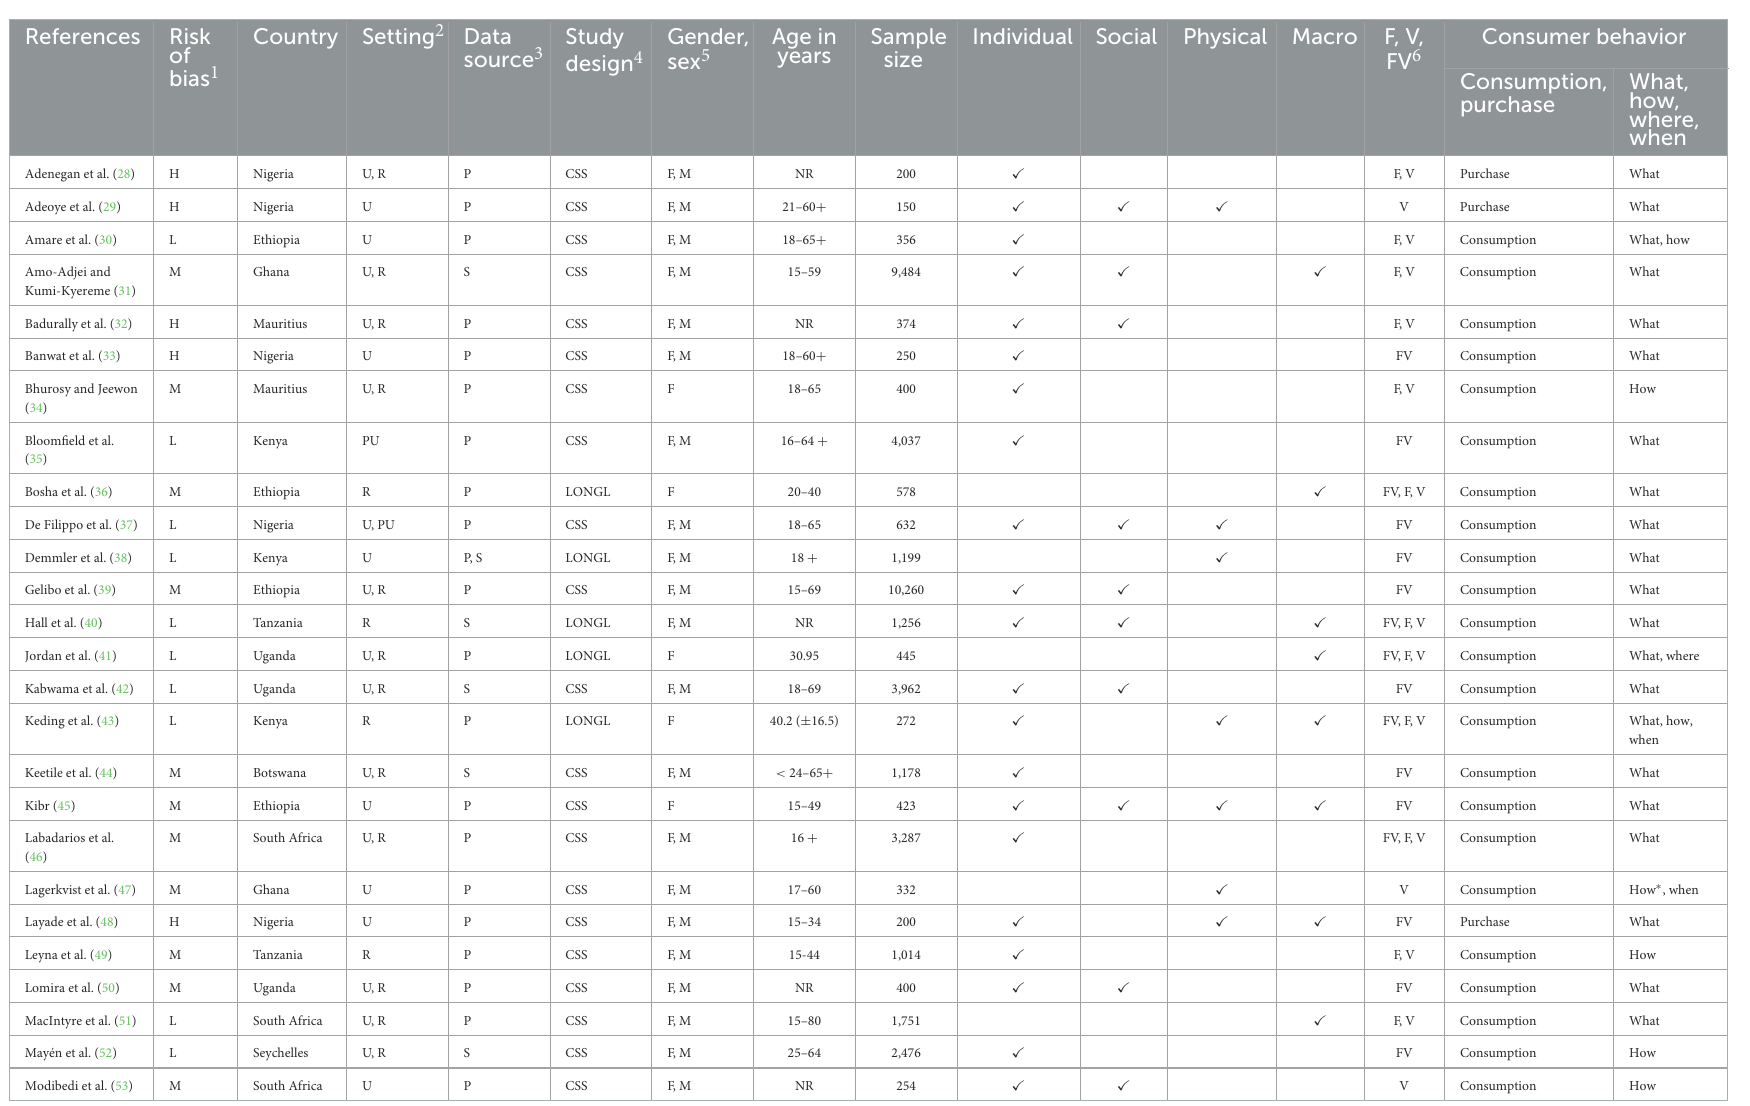
TABLE 1 Characteristics of included